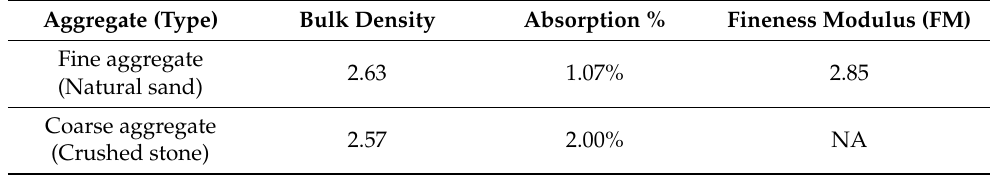
Table 1. Properties of coarse and fine aggregates.